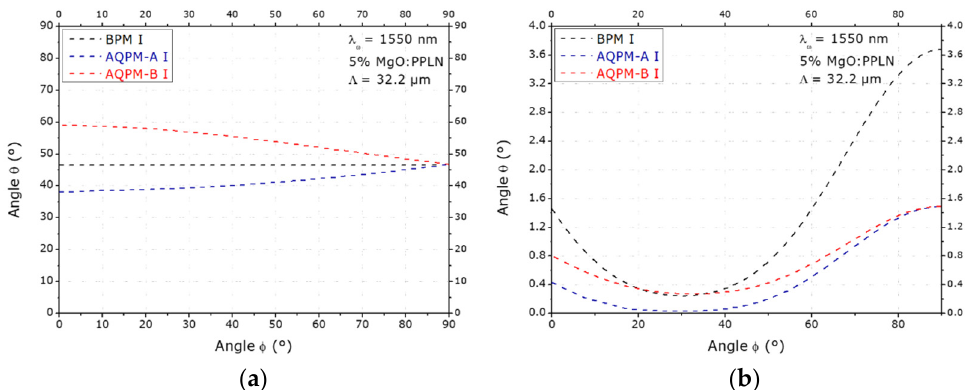
Figure 8. Comparison between AQPM and BPM solutions in the case of a type I SHG interaction at fundamental wavelength λ ω = 1550 nm in 5%MgO:PPLN with a poling periodicity Λ = 32.2 µ m: ( a ) AQPM directions of scheme-A (blue dashed line), scheme-B (red dashed line) and BPM solutions (black dashed line); ( b ) Corresponding Figures of Merit.